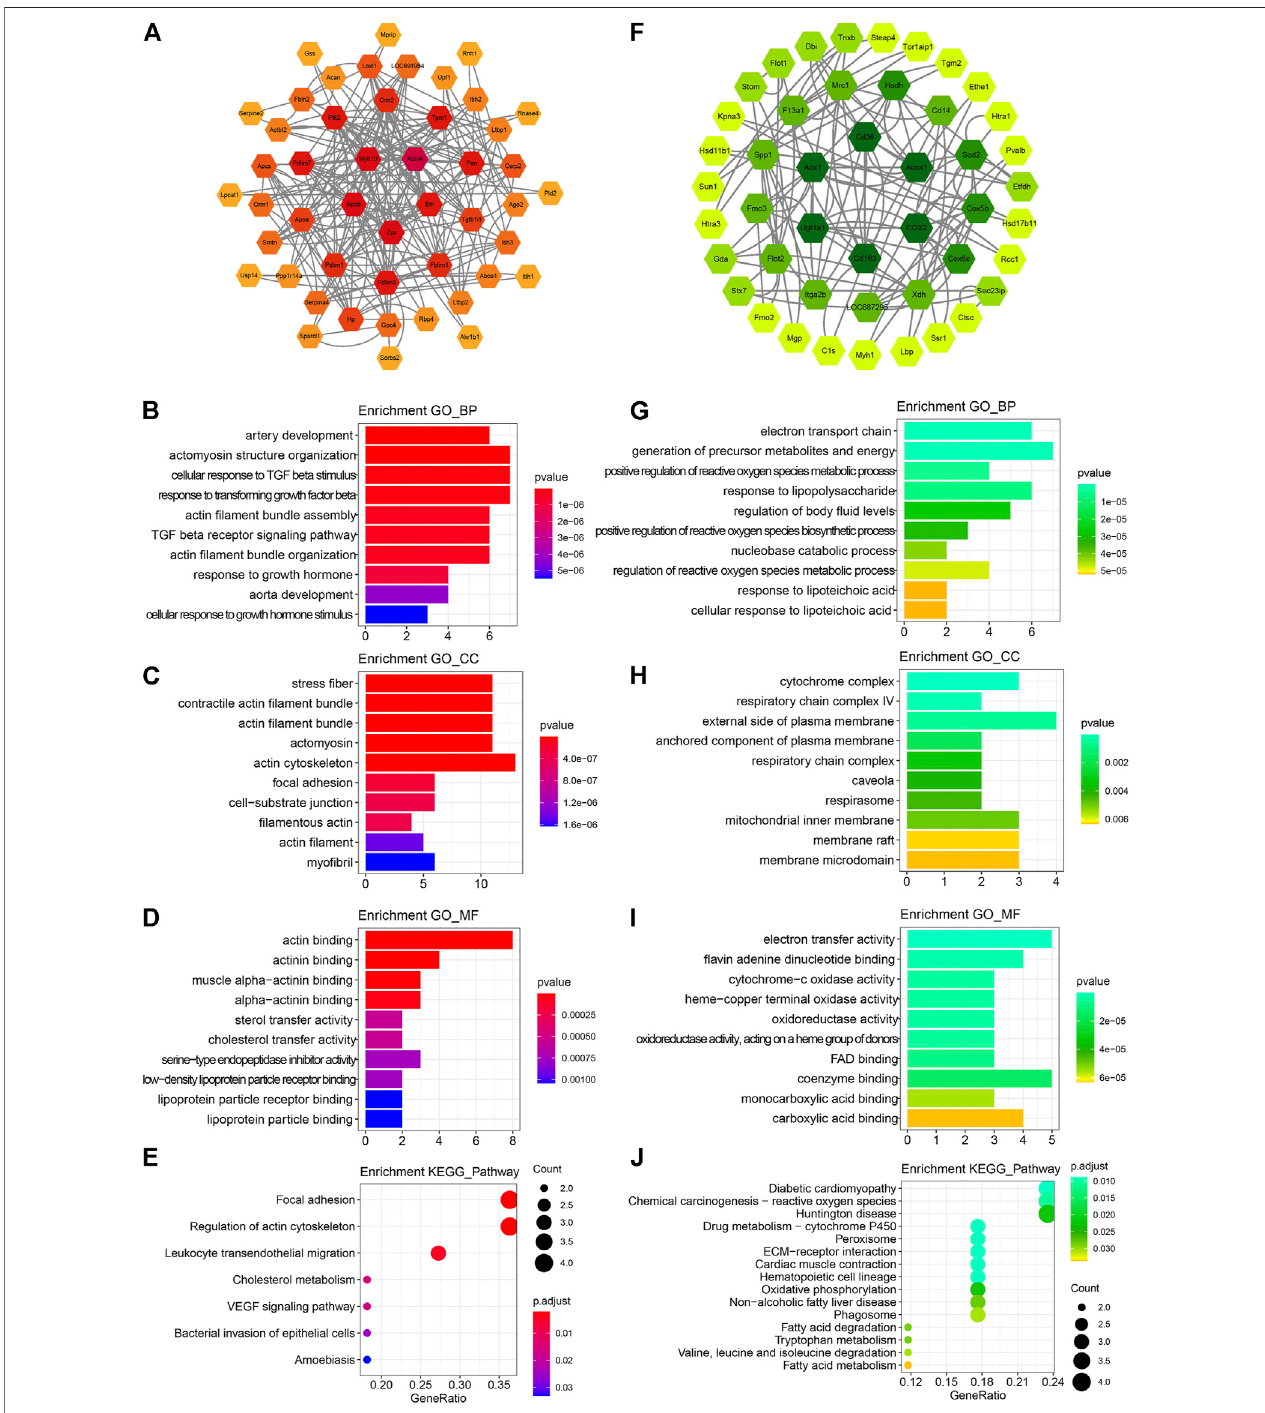
FIGURE 3 | PPI network construction and functional annotation. (A) PPI network construction, (B) biological process, (C) cellular component, (D) molecular function, and (E) KEGG pathway enrichment analysis based on 70 up-regulated DEPs, respectively. (F) PPI network construction, (G) biological process, (H) cellular component, (I) molecular function, and (J) KEGG pathway enrichment analysis based on 75 down-regulated DEPs. DEPs: differentially expressed proteins; PPI: protein – protein interaction; BP: biological process; CC: cellular component; MF: molecular function; KEGG: Kyoto Encyclopedia of Genes and Genomes.